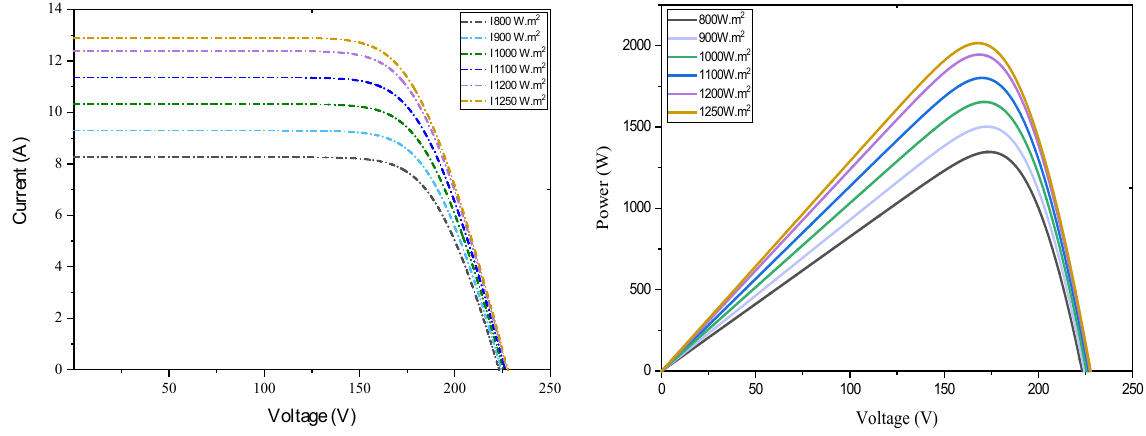
Figure 3. Current-Voltage and Power-Voltage characteristics of GPV under variable irradiance. Table 2. Peak power evolution as a function of irradiance.